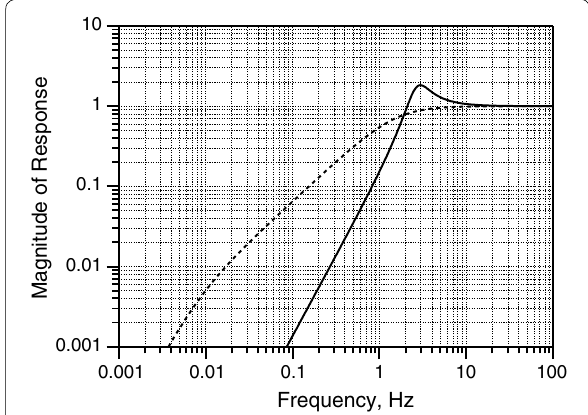
Fig. 9 Theoretical magnitude responses of the mass‑spring systems for the superconducting gravimeter CT #036 in the horizontal (solid line) and vertical (broken line)